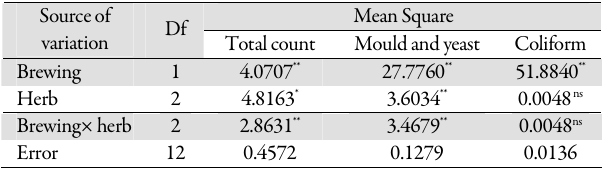
Fig. 2. Mean comparison of mould and yeast in hydro and hydro alcoholic extract